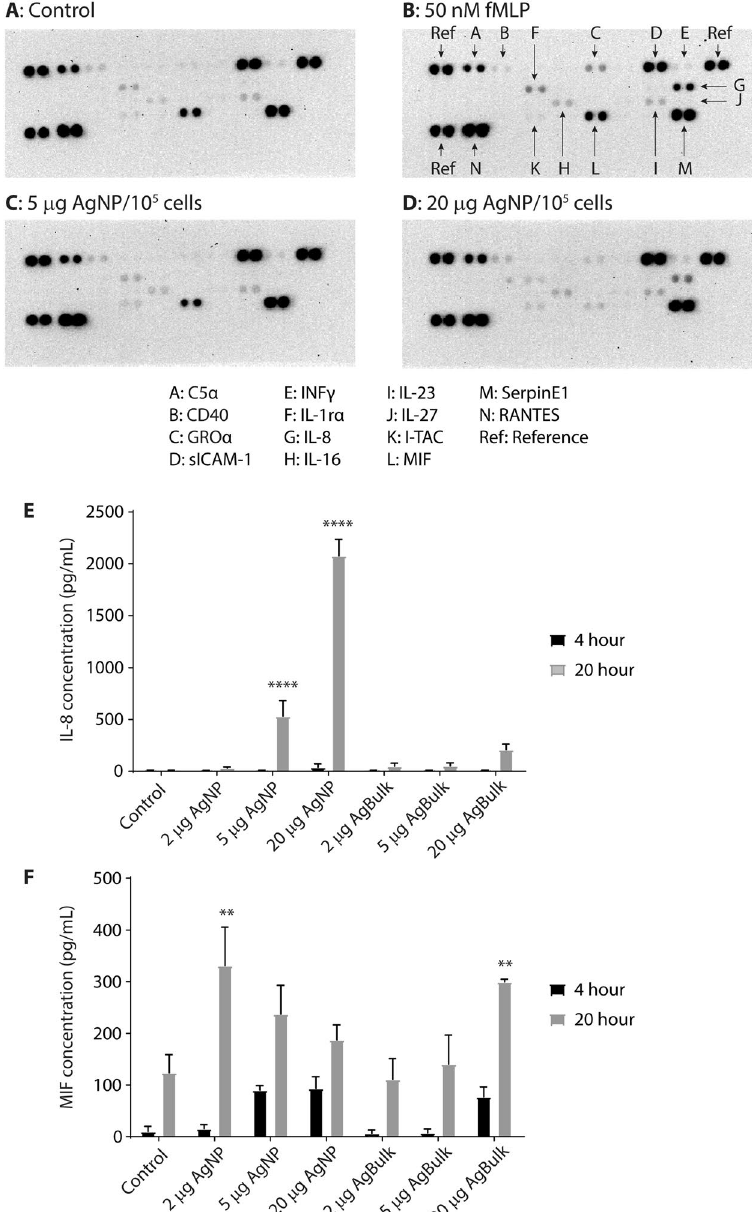
Figure 5. The profile of cytokines released from human neutrophils following exposure to silver nanoparticles. The presence of cytokines in the culture medium from control, untreated neutrophils ( A ) or those exposed to 50 nM formyl-Met-Leu-Phe (fMLP, B ), 5 µ g ( C ) or 20 µ g ( D ) AgNP per 10 5 cells for 4 hr at 37 °C was assessed using a cytokine profiler array. Duplicate spots of interest are numbered and their identity is shown in the key below. The concentration of IL-8 ( E ) or MIF ( F ) released into the culture media from untreated neutrophils (Con) or following exposure to 2, 5 or 20 µ g AgNP or AgBulk particles per 10 5 cells for 4 or 20 hr at 37 °C was further assessed by ELISA. Data is expressed as the mean cytokine concentration ± SEM, where n = 4; ** p < 0.01; *** p <